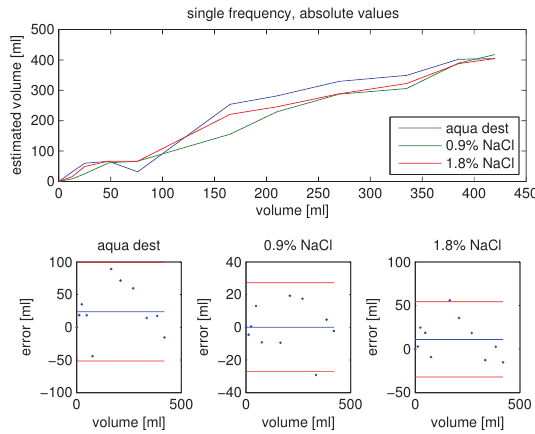
Fig.12: In-vitro results for single-frequency variant using absolute values: the influence of urine conductivity is not suppressed completely.